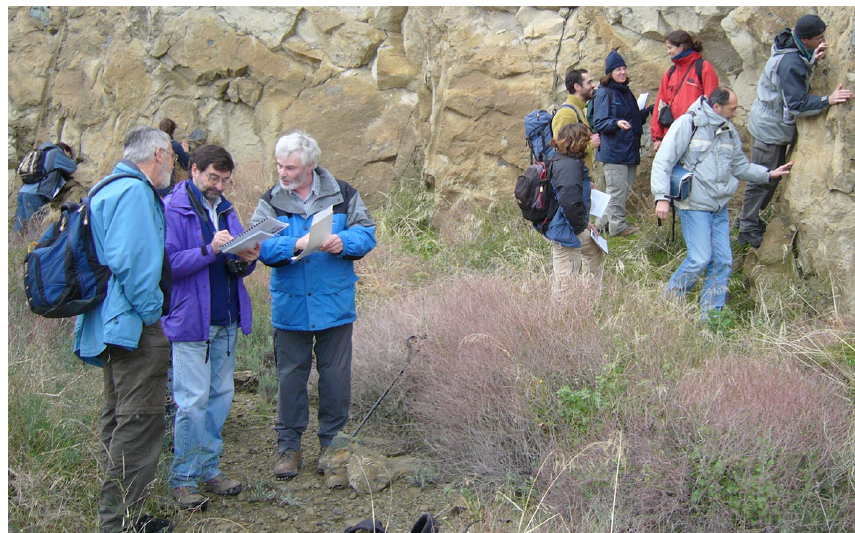
Figure 2. Prof. Andrés Pérez-Estaún in the field with participants in the UK Tectonic Studies Group field trip of